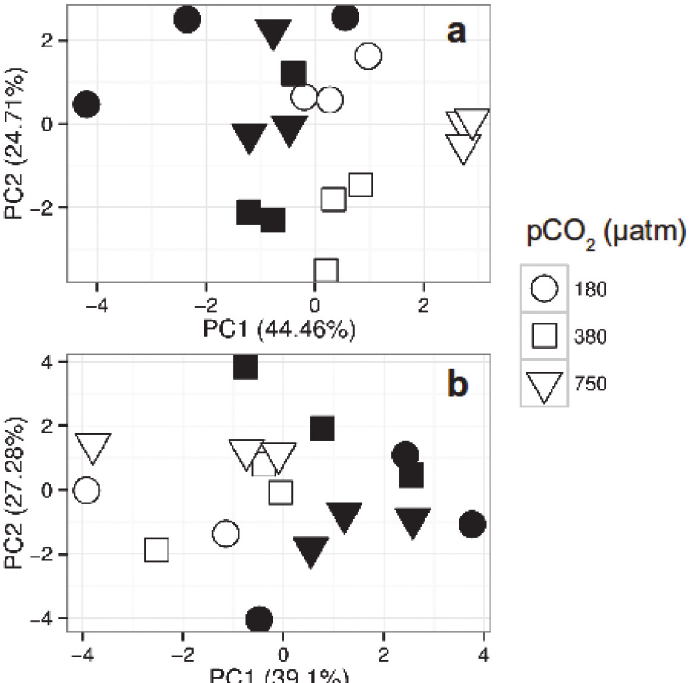
Fig 2. Principal component analysis [PCA] of the fatty acids [FA] and amino acids [AA] in Cylindrotheca fusiformis . The algae was cultured under three different CO 2 conditions and two temperatures (19°C in black and 14°C in white) for > 250 generations. Only the FA and AA with a concentration above 1% were included in the analysis. a) The abundance of essential polyunsaturated fatty acids [PUFA] was higher at 19°C (PC1) and intermediate CO 2 level (PC2), however the influence of the former was lower. b) A higher abundance of essential amino acids [EA] was more common at high temperature (PC1) and intermediate CO 2 level (PC2), although the CO 2 influence was comparatively